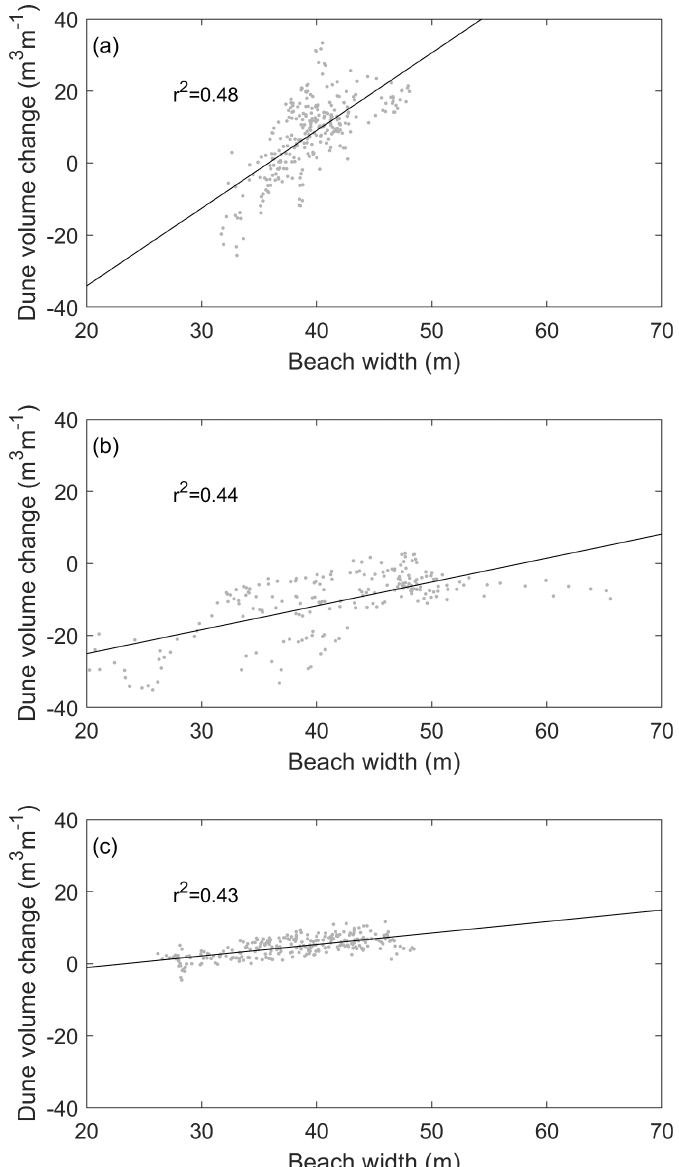
Figure 11. ( a ) total volume change as a function of average beach width (grey points) of 10-m alongshore bins; ( b ) total volume change as a function of beach width at the start of the period for the erosive period Oct14 and Apr15; ( c ) same as ( b ) but for the accretion dominated period Apr15 to and Sep15. Black lines are the best fit linear lines, all of which are statistically significant at the 95% confidence